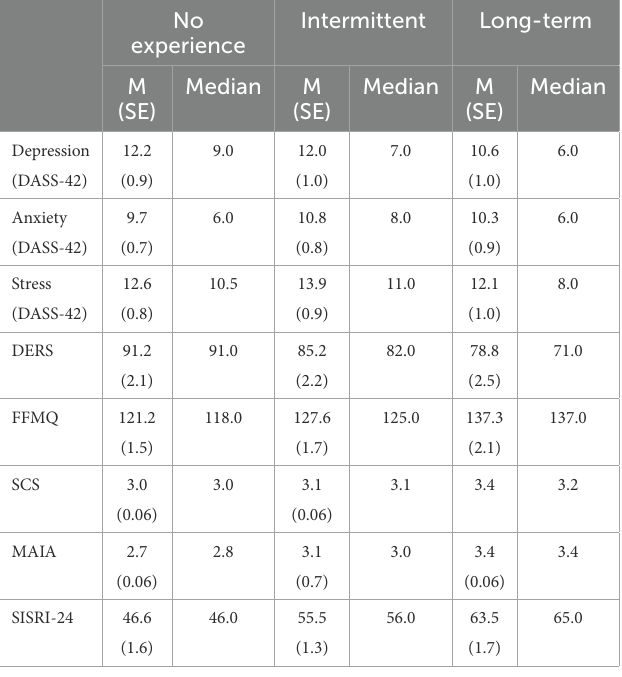
TABLE 4 Summary of scores [mean (M) and